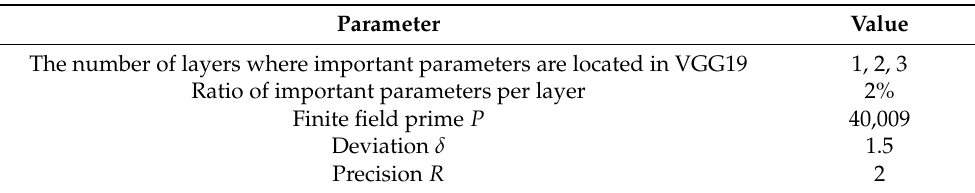
Table 2. The relevant parameters during the experiments. Parameter Value The number of layers where important parameters are located in